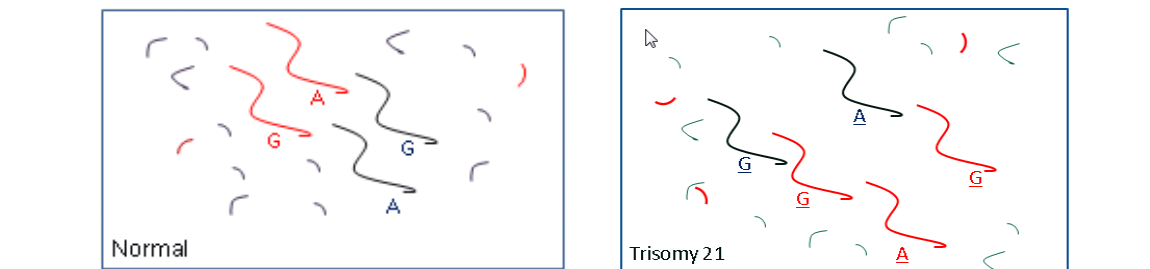
Figure 3. Use of SNPs to detect trisomy 21. Red denotes fetal DNA, black denotes maternal DNA. Left: In this example, for a normal pregnancy, the father is genotyped and known to be GG and the mother GA. The fetus inherited a G allele from the father and A allele from the mother. For a normal pregnancy, the G/A DNA fragment ratio is 1.0 regardless of the fetal fraction percentage. Right: Trisomy 21 is present due to a maternal non-disjunction resulting in a fetal genotype AGG. The G/A fragment ratio will be dependent on the fetal fraction. For example, if the fetal fraction is 20%, the G/A ratio will be approximately ((20% × 2) + (80% × 1))/((20% × 1) + (80% × 1)) = 1.2. The departure from the normal ratio, 1.0, provides evidence for trisomy